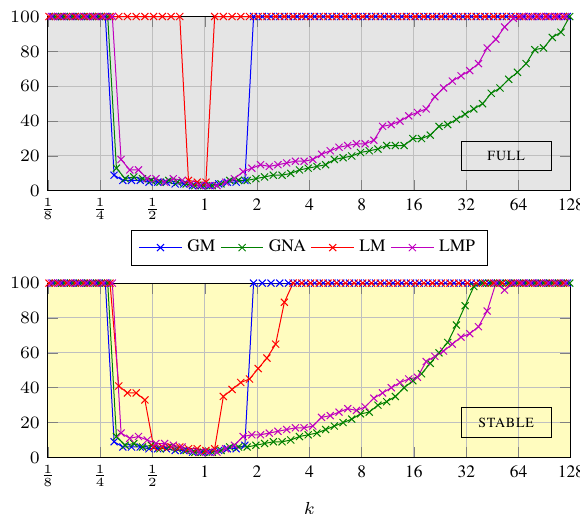
Figure 5: Convergence results for data set 3: The Canon EOS 7D with Sigma lens for the FULL (upper panel) and STABLE (lower panel) experiments. The panels show the number of iterations required for each BA algorithm for varying values of m . A value of 100 indicate failure. Near the true focal length ( m = 1 ), all algorithms converge quickly. Below m = 1 / 4 the resection fails, so neither bundle works. Above approximately m = 2 , the GM (blue) and LM (red) algorithms fail whereas the GNA (green) and LMP (purple) algorithms degrade gracefully and converge up to at least m = 32 .